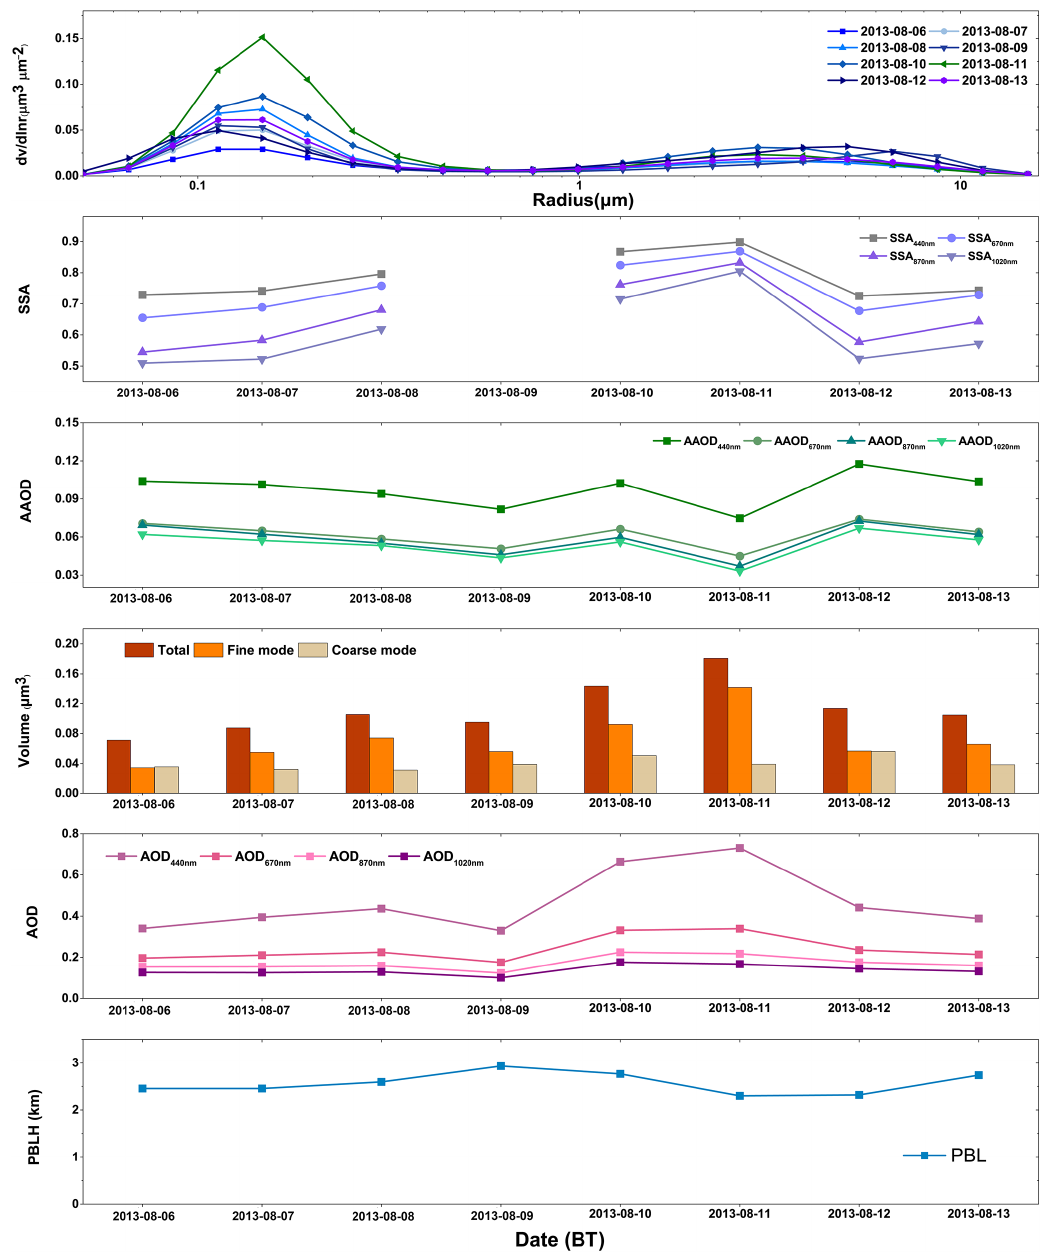
Figure 12. Daily averaged variation of aerosol optical properties and PBLHs in Hangzhou during 6–13 August